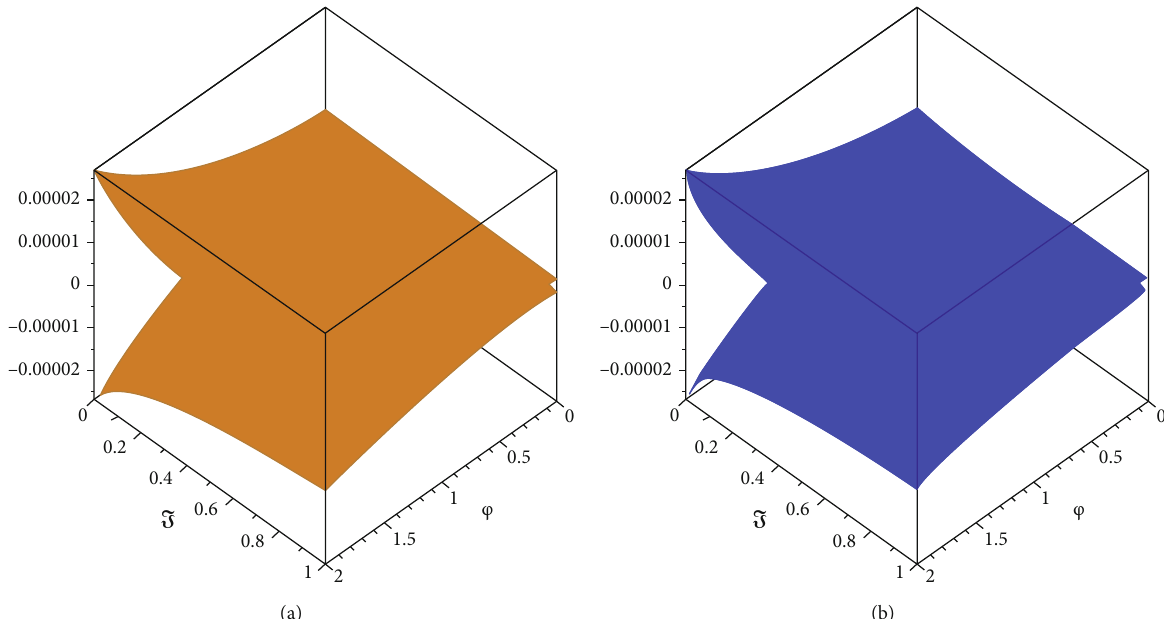
Figure 2: (a) The three-dimensional fuzzy lower and upper branch graph of approximate series result at ϱ = 0 : 6 and (b) at fractional- order of ϱ = 0 : 4 upper branch graph of approximate series result at ϱ = 0 : 6 and Figure 2(b) at fractional-order of ϱ = 0 : 4 . In Figure 3,